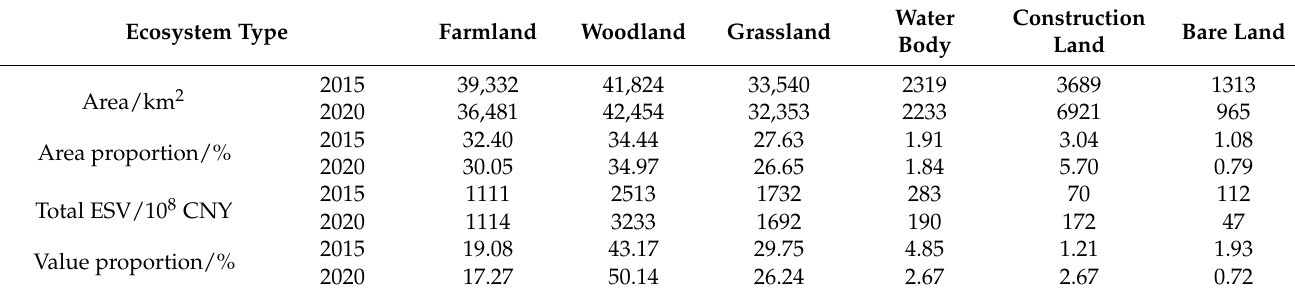
Table 2. Total ESV of study area at ecosystem scale in 2015 and